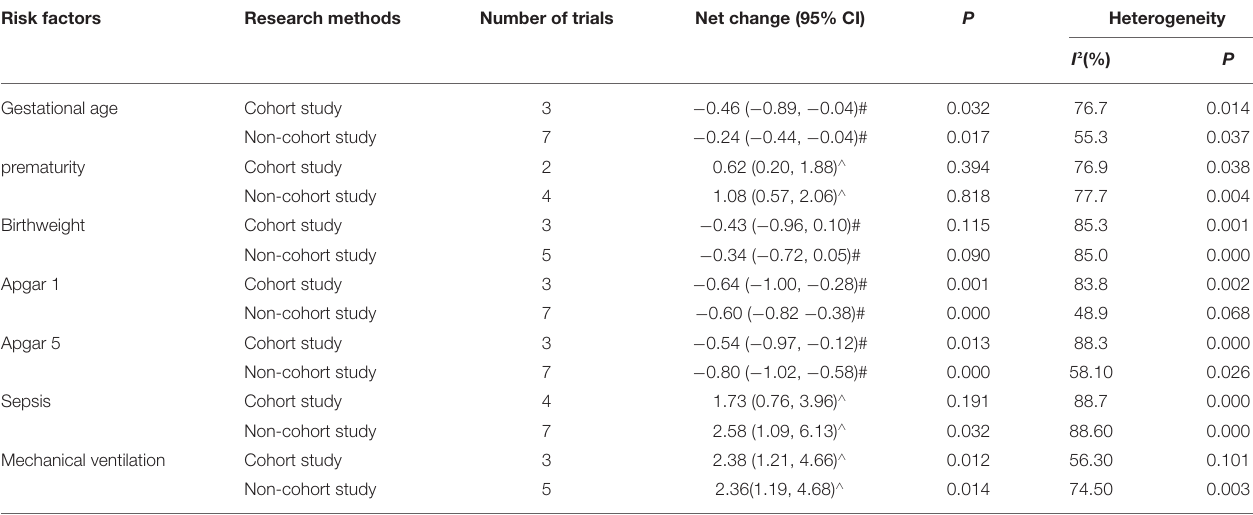
TABLE 6 | Subgroup analyses based on the research method.